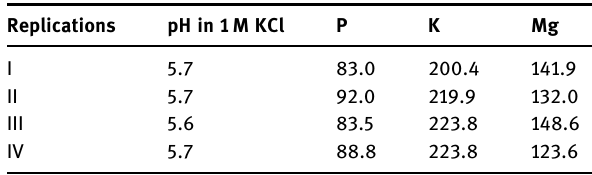
Table 2: Soil ’ s abundance in macroelements ( mg kg − 1 ) and soil pH value ( 1 M KCl )